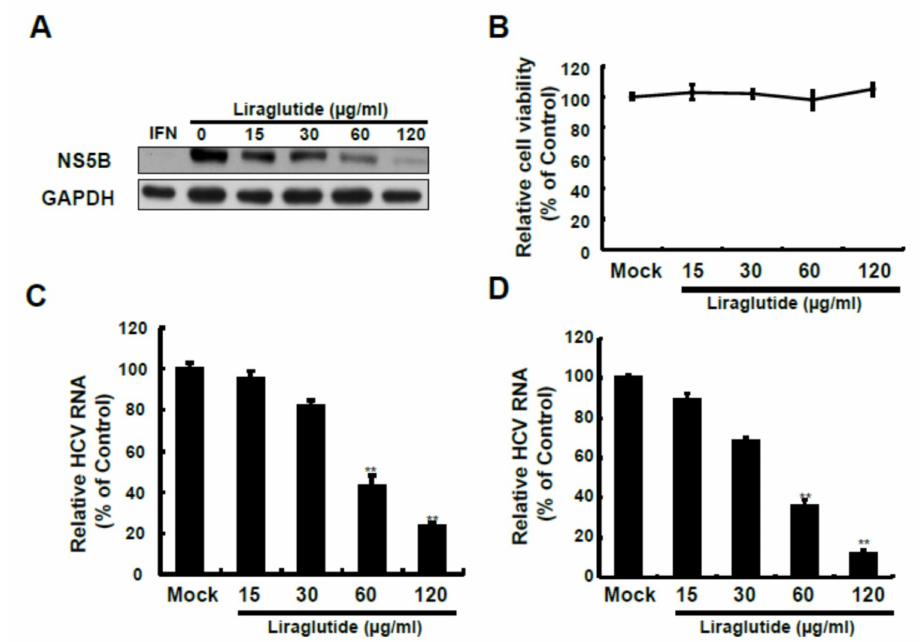
Figure 1. E ff ects of liraglutide on HCV protein synthesis and RNA replication. ( A , B ) Liraglutide inhibits HCV protein synthesis without cytotoxicity. Ava5 cells were treated with liraglutide with indicated concentrations. The cell lysate was extracted and the protein synthesis was analyzed by Western blot using anti-HCV NS5B and anti-GAPDH (loading control) antibodies. Cellular toxicity was determined by the MTS assay. Liraglutide inhibits HCV RNA replication in replicon ( C ) and infectious ( D ) systems. Ava5 and JFH-1-infected Huh-7 cells were treated with liraglutide with indicated concentrations for 3 days. The total RNA was extracted and intracellular HCV RNA levels were normalized by cellular GADPH mRNA expression which were quantified by qRT-PCR. The results shown are presented as the percentage ± standard deviations (SD) from 3 independent experiments. ** p < 0.01, as assessed using the Student’s t -test for quantification of real-time PCR threshold values from each individual experiment and